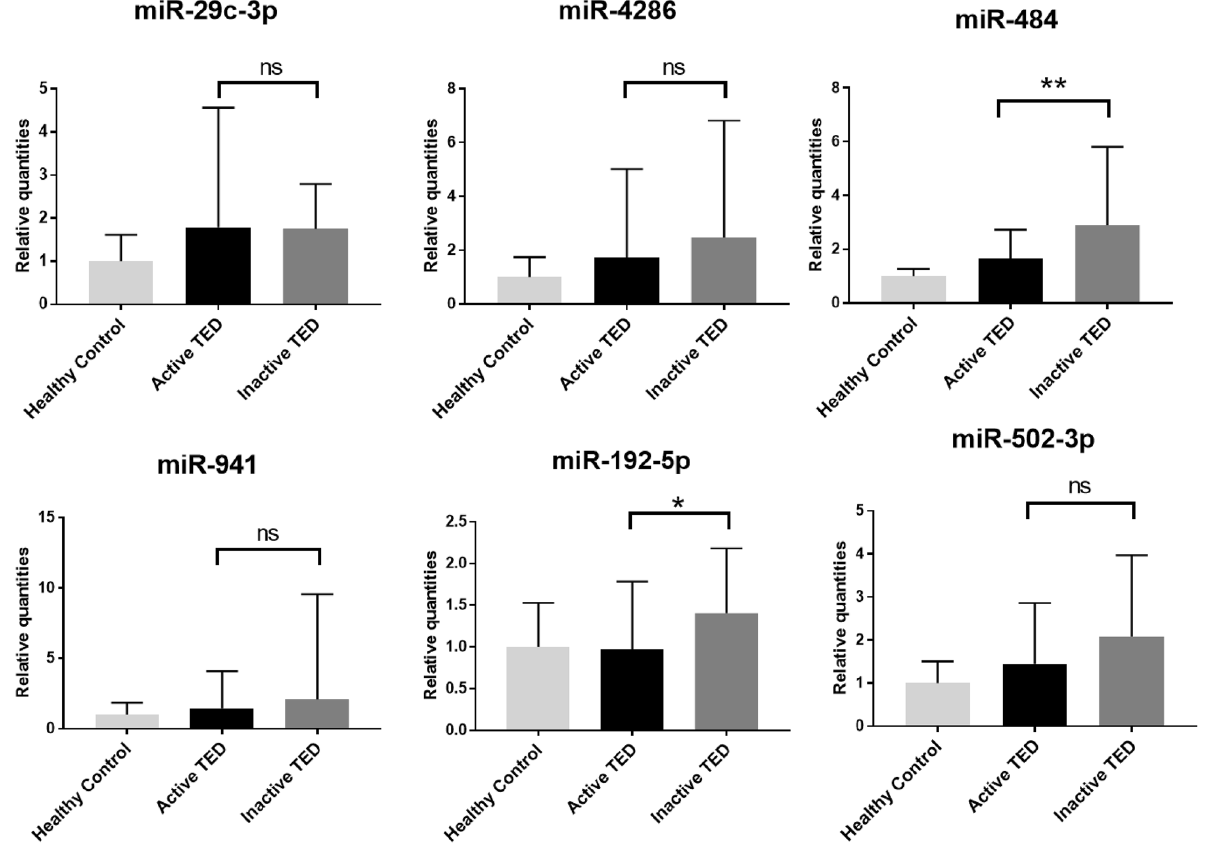
Figure 2. Analysis of serum samples from validation cohort using quantitative RT-PCR (healthy control (n = 4), active TED (n = 10), and inactive TED (n = 10), *p < 0.05, **p <